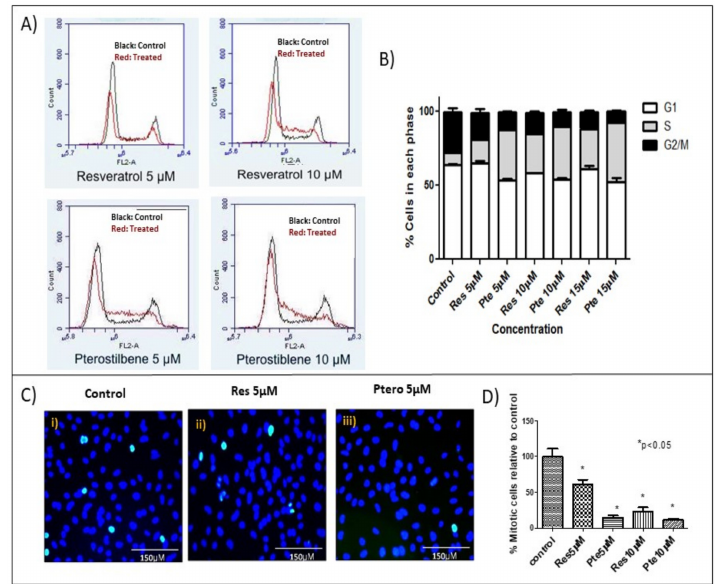
Figure 3. S-phase arrest in HeLa cells treated with low concentrations of resveratrol and pterostilbene: ( A ) Flow-cytometric evaluation of HeLa cells untreated or treated with sub-lethal doses of resveratrol (Res) and pterostilbene (Pte) for 18 h. Treated cells exhibited S-phase arrest and a subsequent decrease in the number of cells in G2/M. Pterostilbene was a more potent compound than resveratrol, showing a capacity to arrest cells at the S-phase at concentrations as low as 5 µ M. ( B ) Graphical representation of the dose-dependent cell cycle effects induced by resveratrol and pterostilbene at three different concentrations (5 µ M, 10 µ M, and 15 µ M). ( B ) The graph represents data from triplicate sample experiments normalized to the control (mean % cells in each phase ± S.E.M.) ( C ) Immunofluorescent images of HeLa cells probed for the M-phase marker phospho-histone-H3 (serine10). HeLa cells were untreated or treated with 5 µ M and 10 µ M of resveratrol or pterostilbene. Immunofluorescent images display a decrease of histone-H3 in cells treated with both the compounds, the effects at 5 µ M of pterostilbene is much greater than those of resveratrol (at 5 µ M). ( D ) Graphical representation of the percent of mitotic cells calculated from immunofluorescent images reveal that resveratrol and to a greater extent pterostilbene are effective in decreasing the number of mitotic HeLa cells. The graph represents data from experiments obtained from triplicate samples normalized to the control (mean % mitotic cells ± S.E.M.;* p <